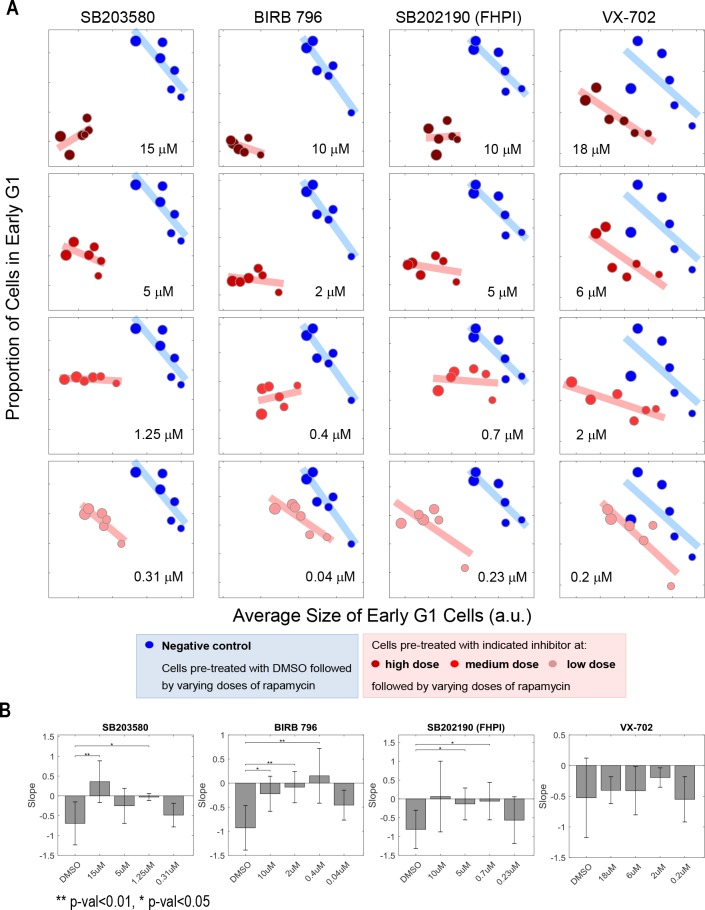
Inhibitors of p38 display dose-dependent influence in the coordination of cell size and G1 length.The p38 inhibitors and three higher concentrations shown here are also included in Figure 2D and Figure 2—figure supplement 2. (A) Cells treated with only rapamycin concentration series (blue) display negative correlation between cell size and proportion of cells in G1. However, the negative correlation between cell size and proportion of cells in G1 disappears or weakens when cells are co-treated with p38 inhibitors and the rapamycin concentration series (red). The blue and red lines show the result of linear regression. The rapamycin concentration range is as follows: 0, 0.03, 0.1, 0.3, 3 and 30 nM. (B) The fitted slope of measurements shown in (A) For each compound treatment, its fitted slope is compared with the slope of the control (DMSO) from the same experiment. Significance was calculated with one-tailed Student t-test (H0: slopedrug <= slopecontrol). The meta data and source code used for the analysis and visualization of the results is presented in Figure 2—source data 1.